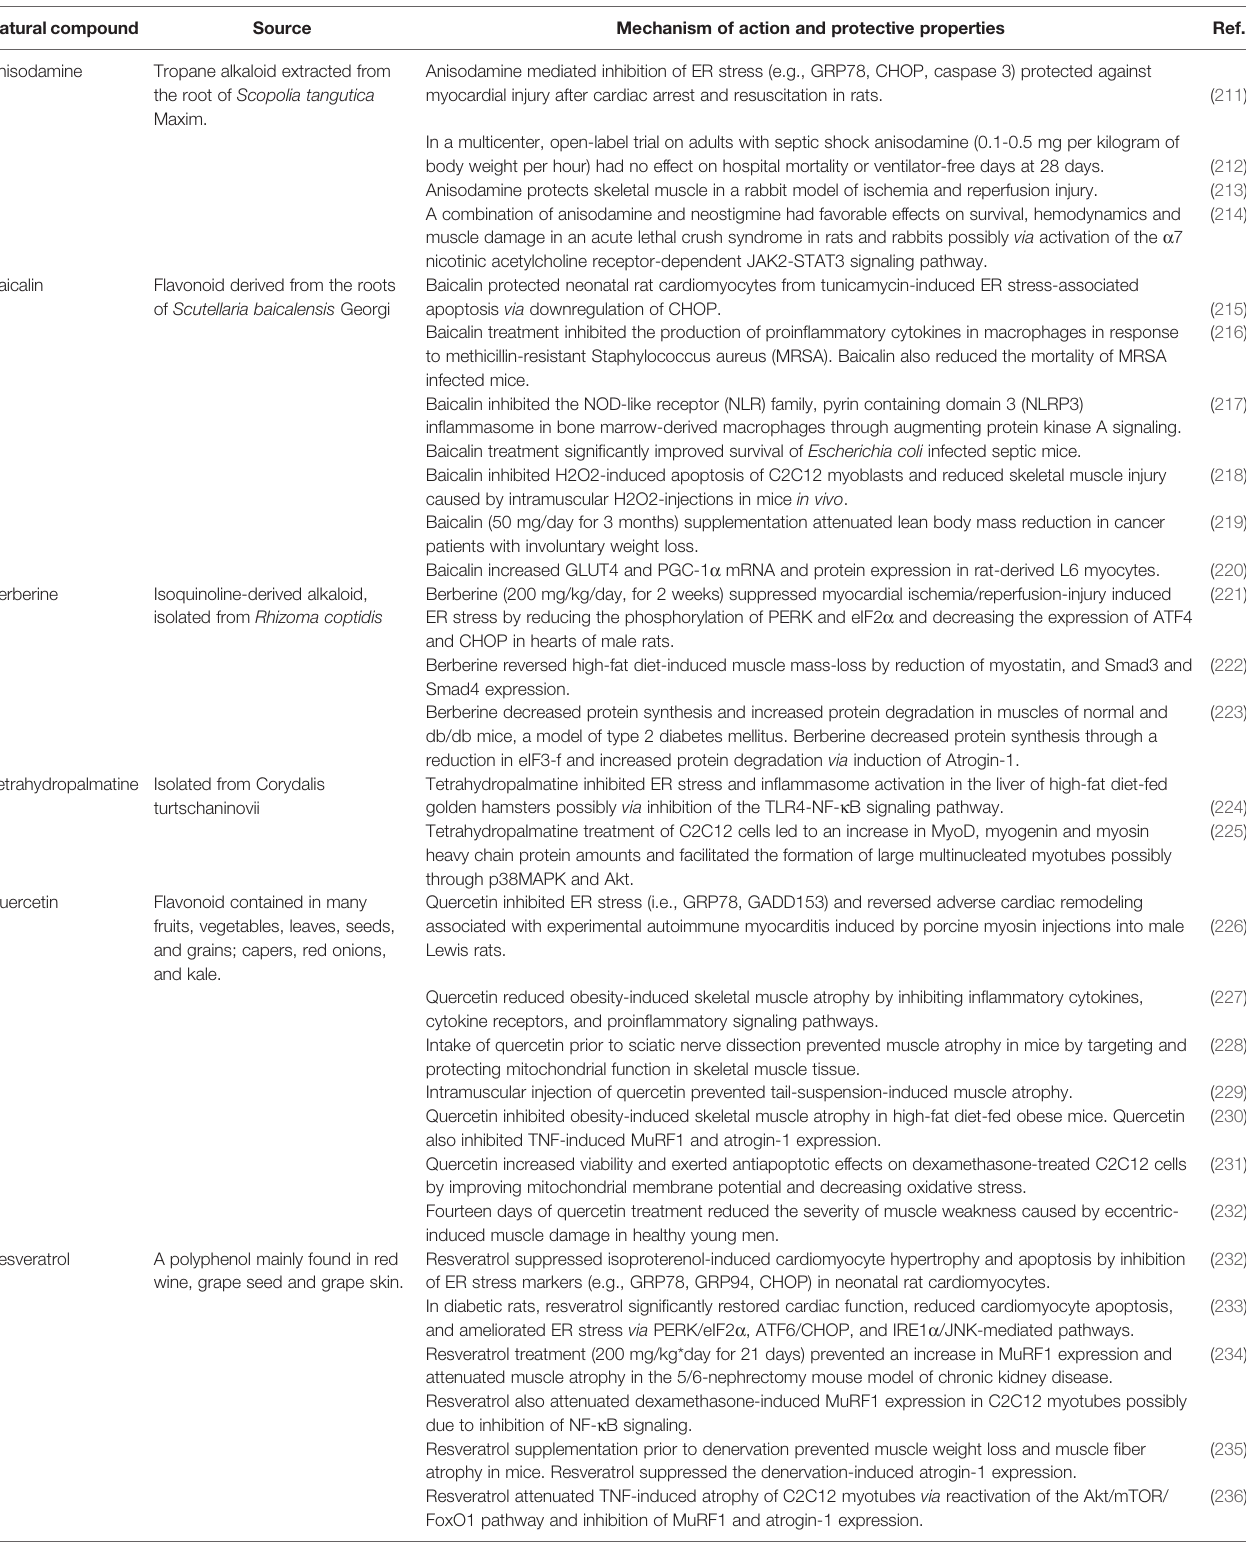
TABLE 2 | Natural compounds with effects of ER stress and UPR in